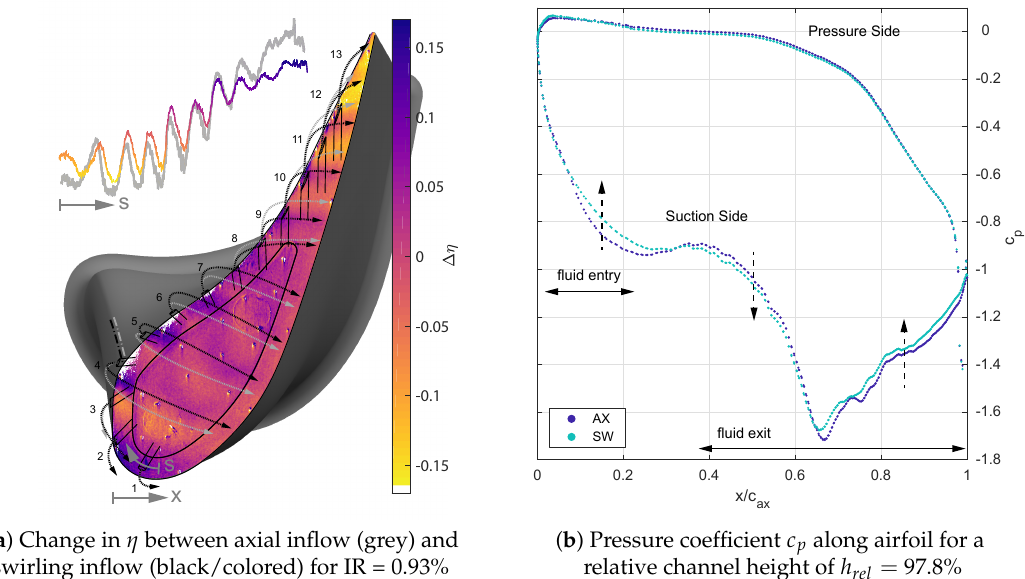
Figure 7. Comparison between swirling inflow and axial